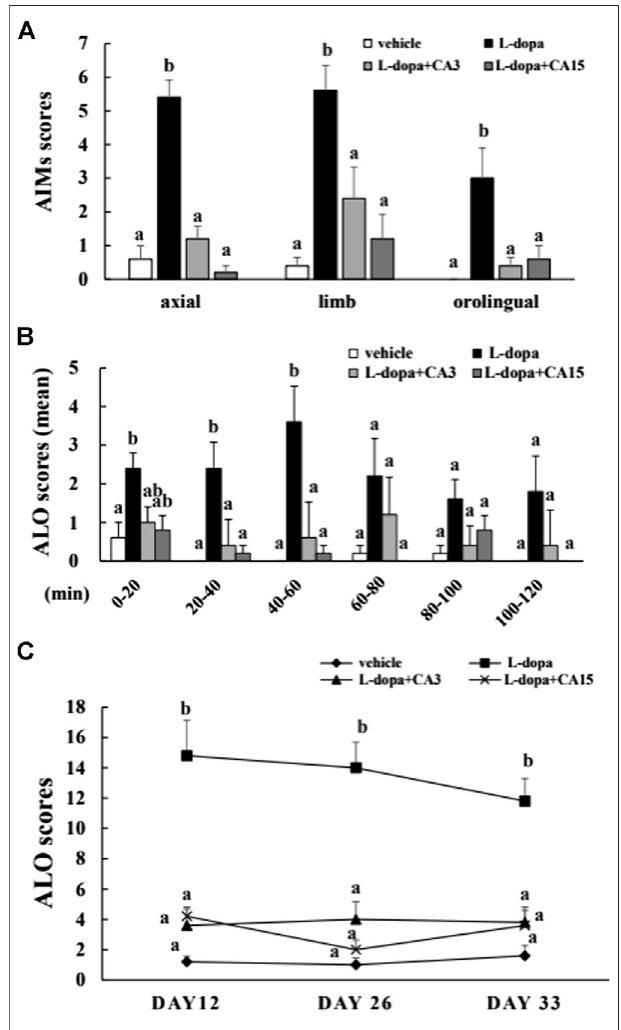
FIGURE 1 | Effect of CA on L -dopa-induced abnormal involuntary movements (AIMs) in 6-OHDA lesioned rats. The axial, limb, and orofacial AIMs were calculated on days 12, 26, and 33 for 1 min every 20 min over 120 min. (A) The integrated AIM scores of axial, limb, and orofacial subtype on day 26 over 120 min. (B) The ALO score (the sum of axial, limb, and orofacial) on day 26 for 1 min every 20 min over 120 min. (C) The ALO score on days 12, 26, and 33. The results are expressed as mean ± SEM ( n (cid:1) 5). Means without a common letter differ, p <